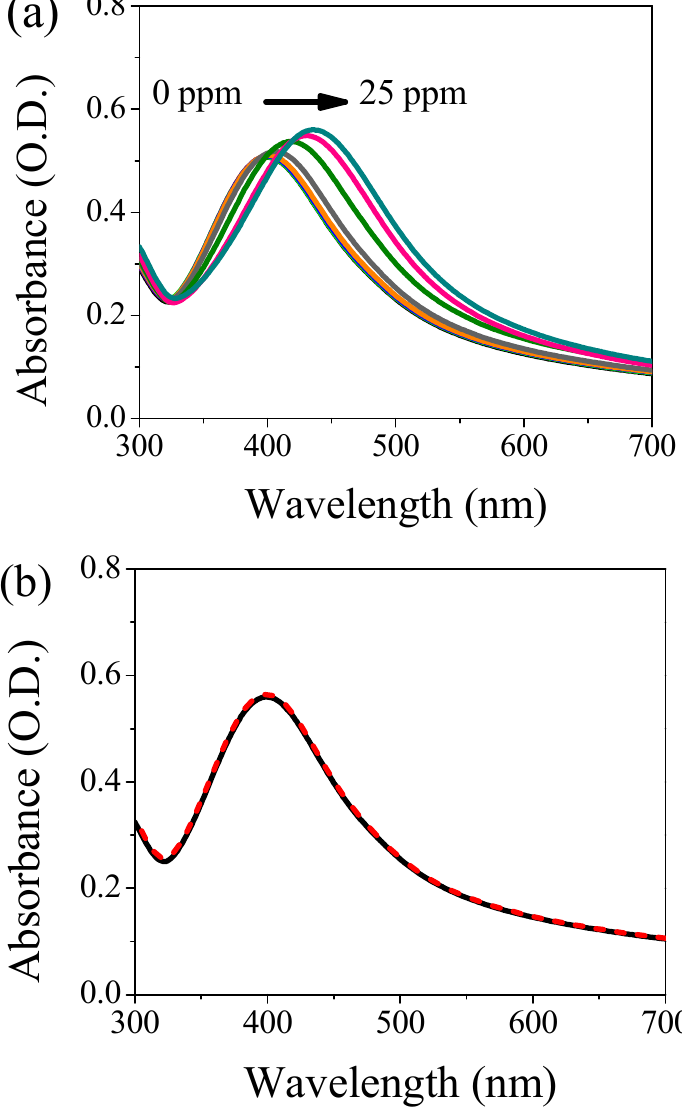
Figure 2. UV-Vis absorption spectroscopy of AgNPs/L-cys/citr in presence of: ( a ) different concen- trations of Cd(II) ions (represented with different colors) and ( b ) 25 ppm of As(III) ions where the black curve represents the reference (unpolluted sample), while the dashed red curve refers to the contaminated specimen.